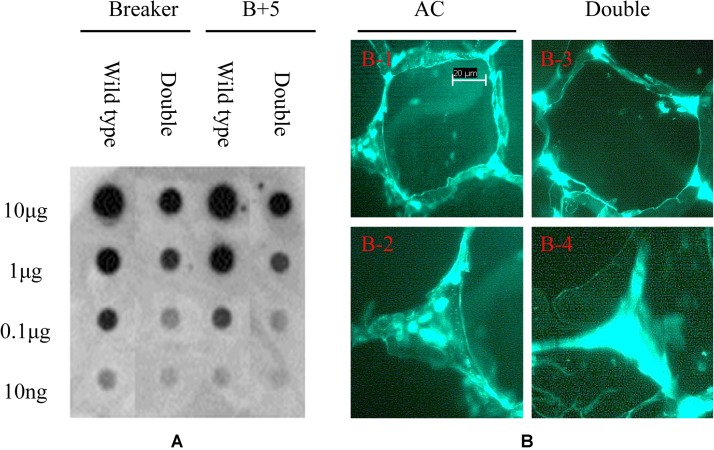
Immunodot blot and immunolocalization analysis of tomato fruit cell wall. Pectin was extracted from tomato wild-type and PE1/PE2 antisense fruit pericarp and loaded onto nitrocellulose membrane for dot blot analysis using monoclonal antibodies of JIM5 (A). Immunolabeling of tomato pericarp with monoclonal antibody JIM5 (B).